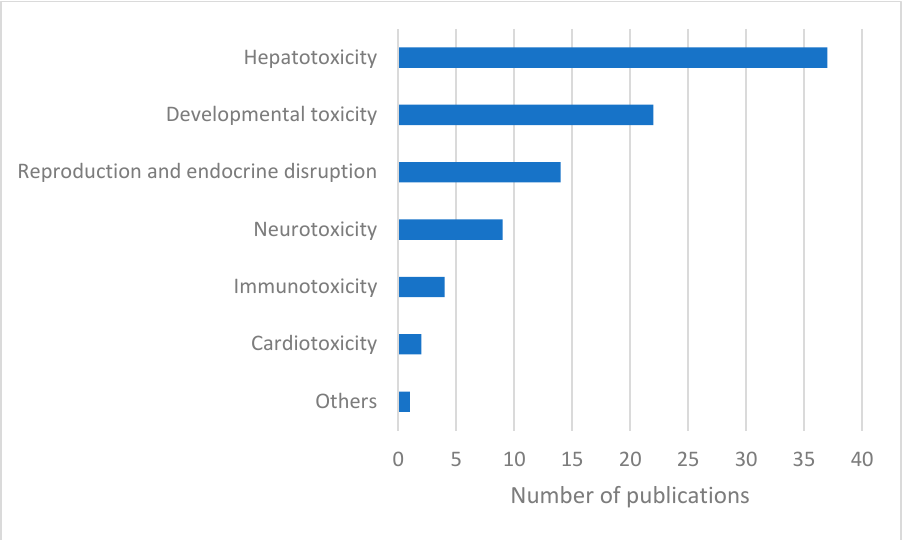
Figure 2. Number of publications on the contribution of proteomics to human toxicology of POPs, classified by toxicity type. Table 1. Articles describing POP-induced hepatotoxicity.